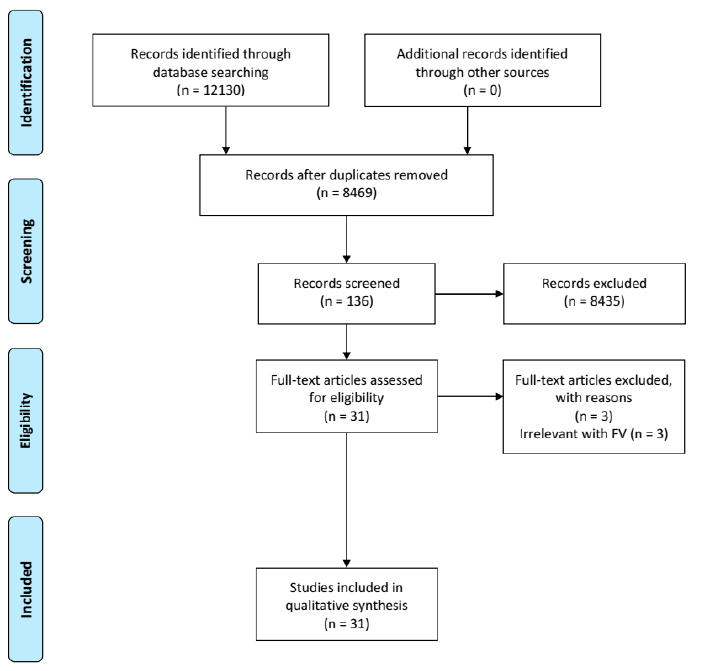
Figure 1. Article selection